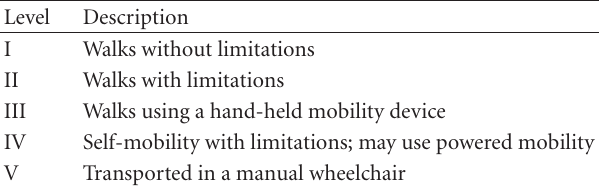
Table 1: Gross motor function classification system (GMFCS E&R) levels for children with cerebral palsy 6–18 years